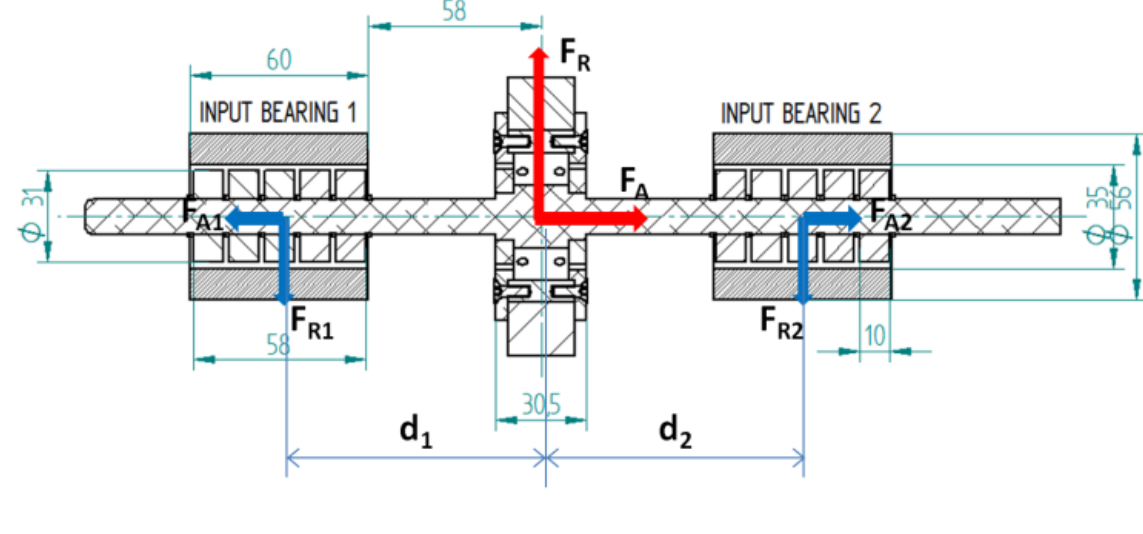
Figure 3. Mechanical drawing plan of the input axle